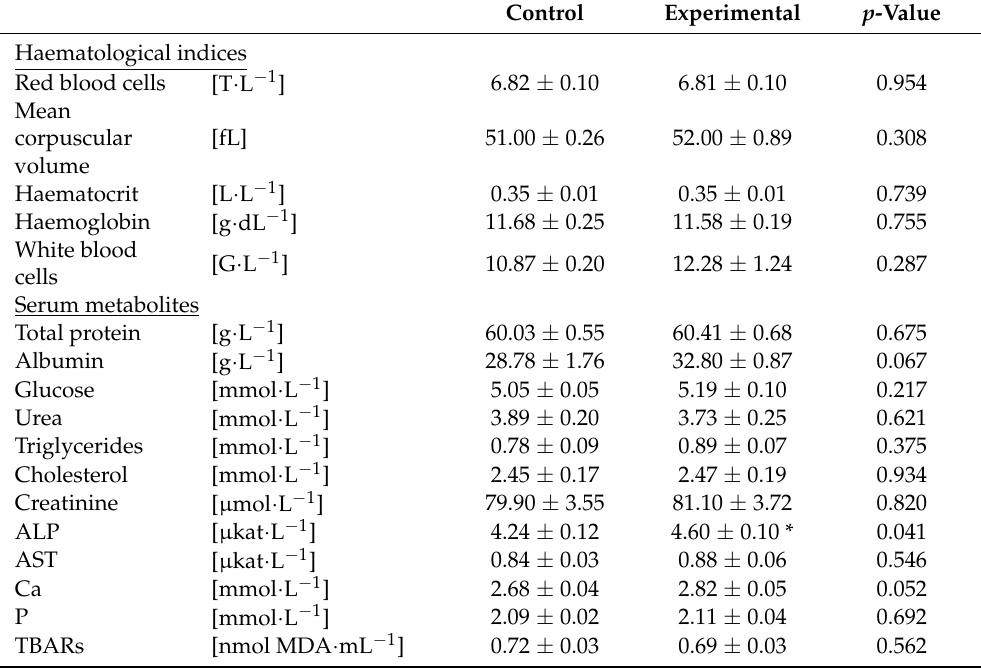
Table 3. Effect of humic substances on some haematological and serum biochemical parameters in piglets.